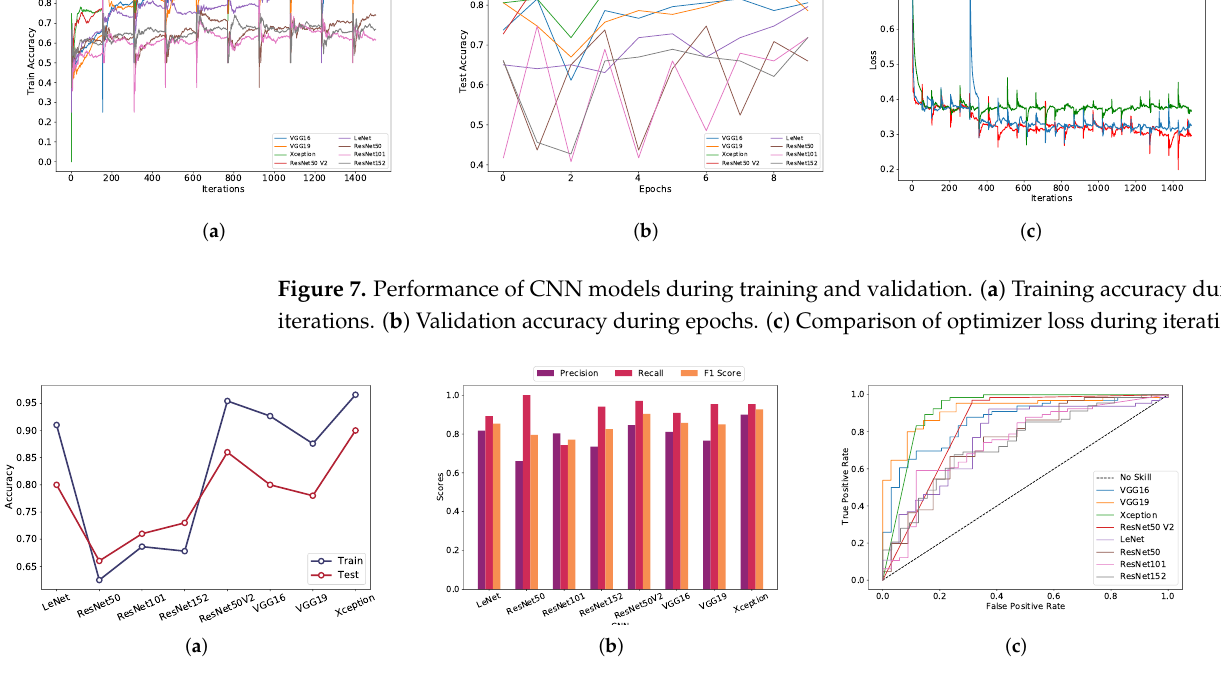
Figure 8. Comparison of CNN architectures on different evaluation metrics. ( a ) Train and test accuracy curve. ( b ) Precision, recall, and F1 score. ( c ) ROC-AUC